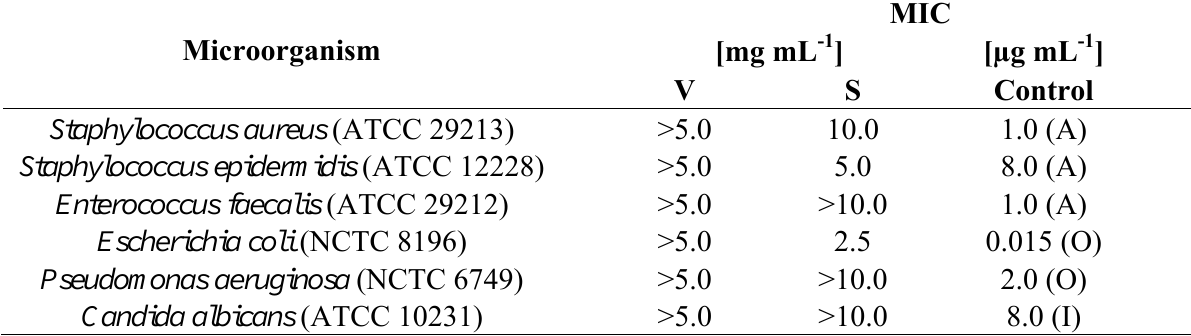
Table 2. Antimicrobial activity of S. sclarea essential oils. MIC values were determined by the microdilution assay, according to CLSI recommendations.